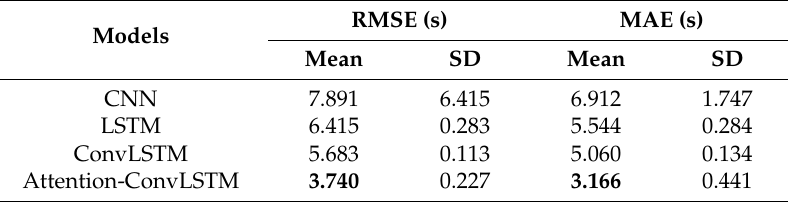
Table 4. Performance comparison of the bus waiting time prediction models for a